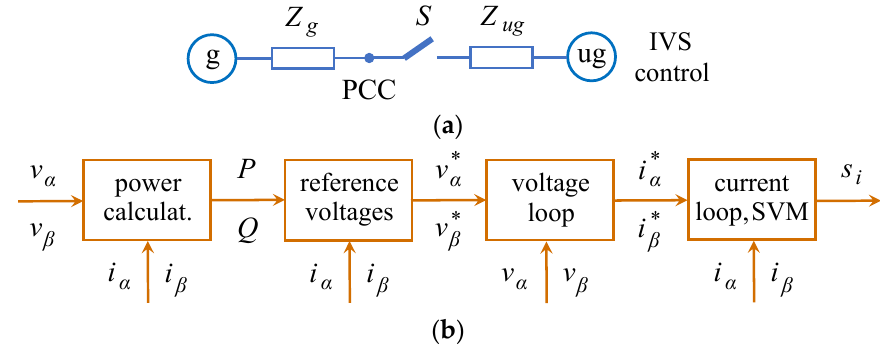
Figure 4. IVS control scheme: ( a ) diagram of the power system; ( b ) diagram of the control scheme.